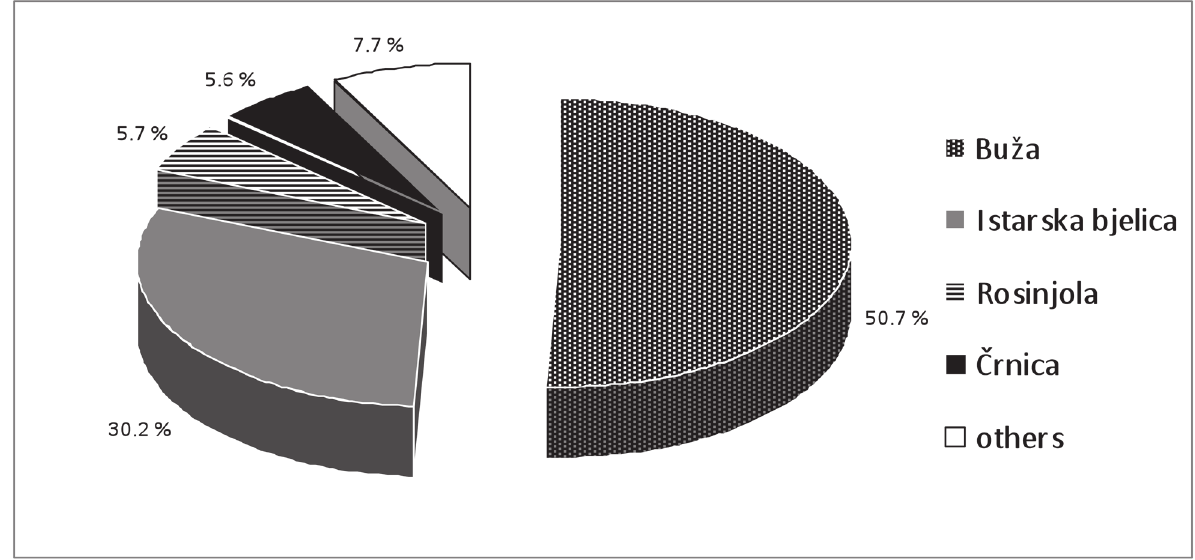
Figure 1. Proportion of area in production of the local olive varieties in Croatian Istria (Pribetić,